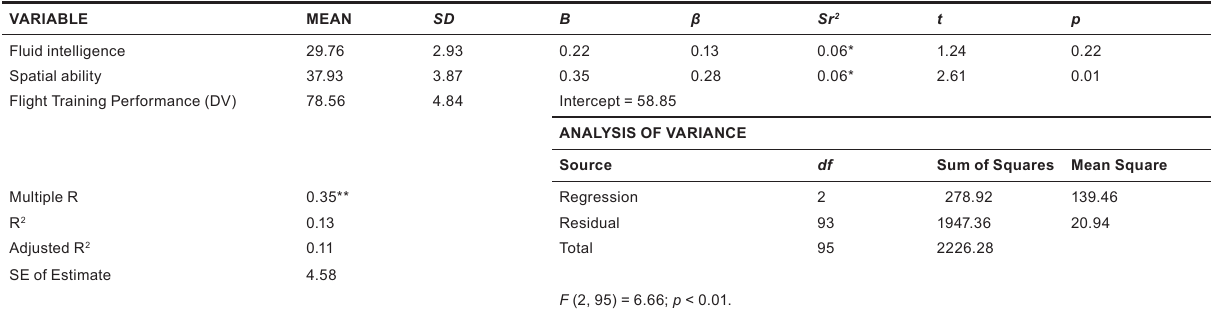
taBle 3 Summary of hierarchical regression analysis for variables predicting flight training performance